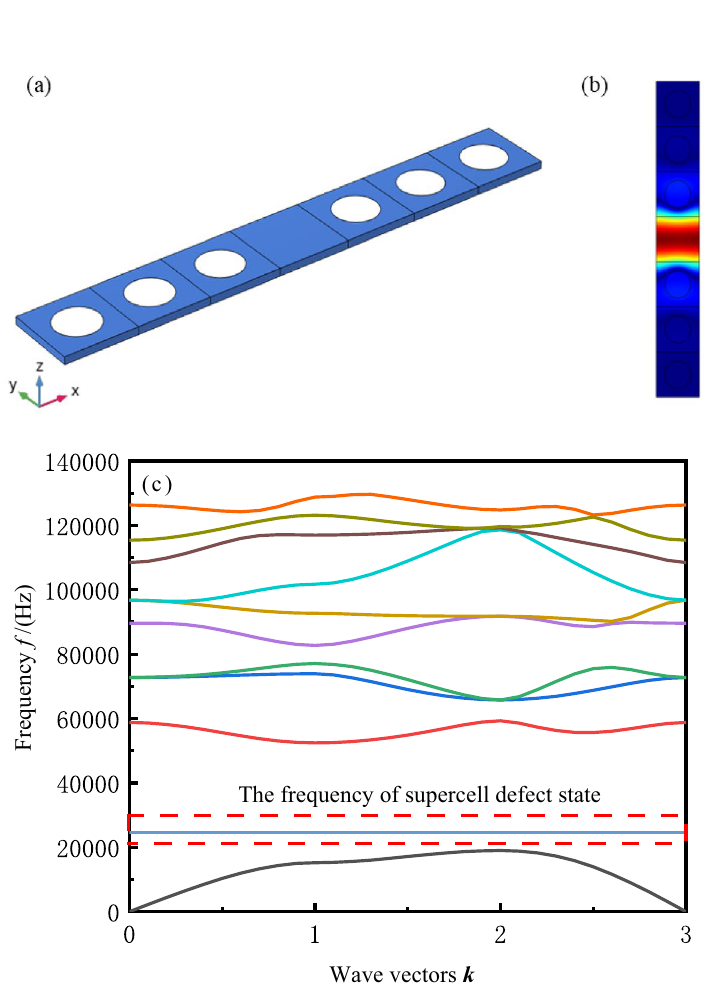
Figure 4. PnC supercell defect state where ( a ) is 1 × 7 supercell structure diagram with one defect, ( b ) is Anderson localization effect of defect states at 24,560 Hz, and ( c ) is supercell defect